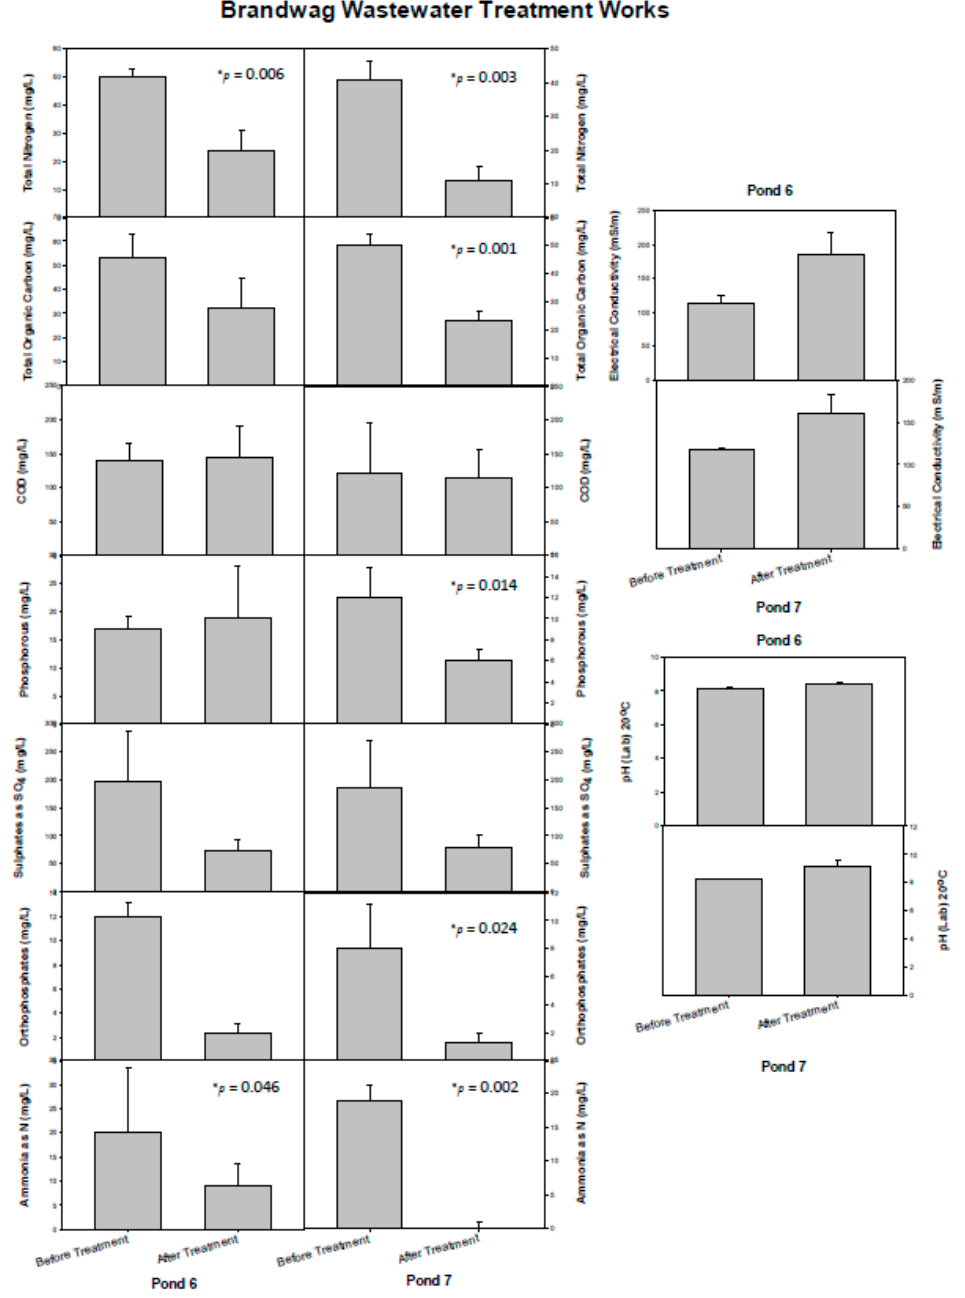
Figure 3. Water quality results from Brandwag wastewater pond treatment before and after phycoremediation treatment. * p -values shown for those parameters that were statistically signifi- cantly different before and after treatment.